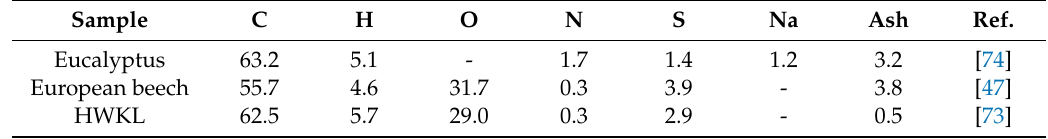
Table 5. Elemental composition of hardwood kraft lignins